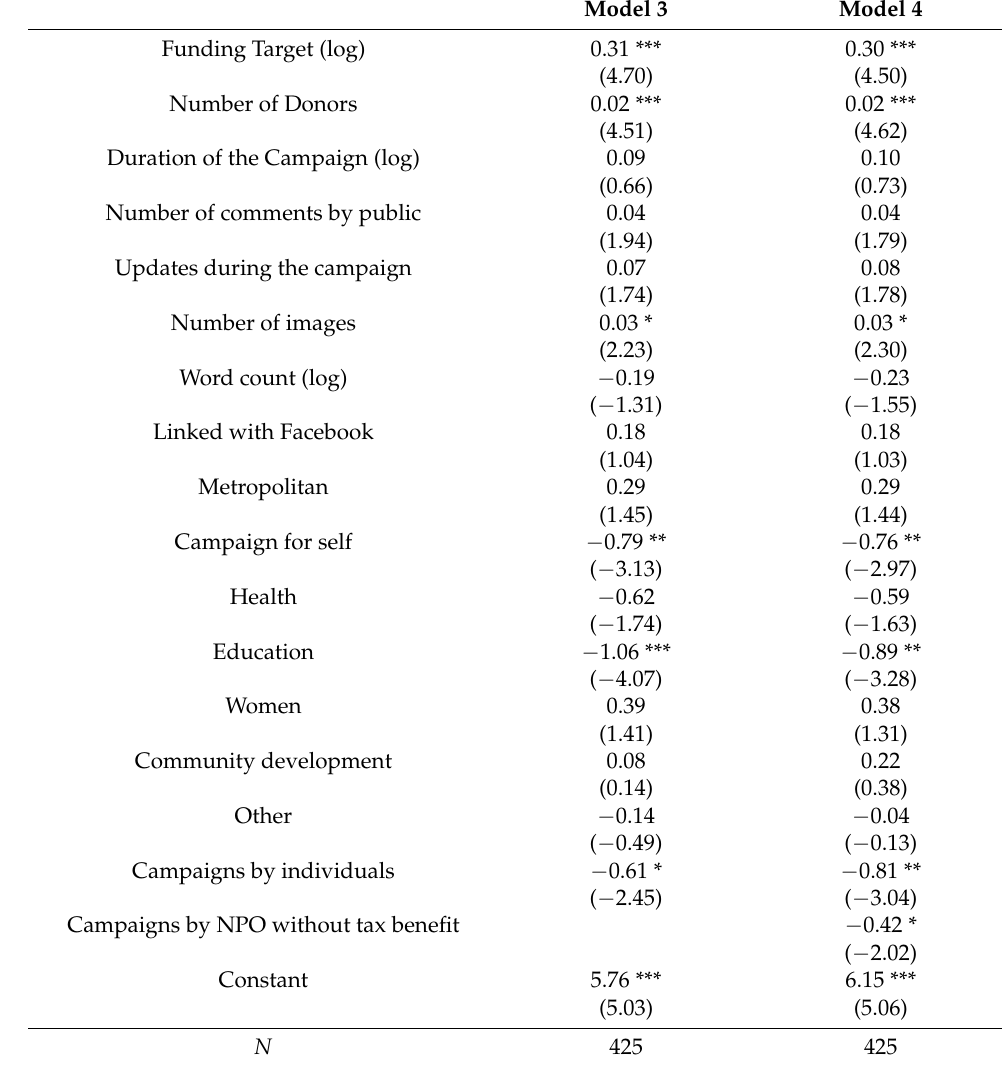
Table 5. Regression results for funding amount